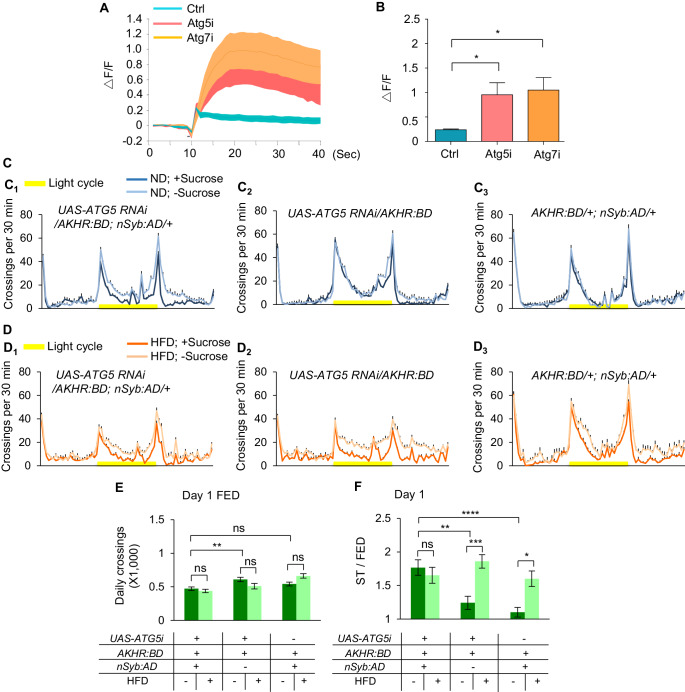
Inhibition of autophagy increases starvation-induced hyperactivity.(A–B) Representative traces (A) and quantification (B) of peak calcium responses of AKHR+ neurons to 316 nM AKH upon suppressing neuronal autophagy in AKHR+ neurons (n = 7–10). (C–D) Midline crossing activity of indicated genotypes and diet treatments assayed in the presence or absence of 5% sucrose (n = 43–62). (E) Average daily midline crossing activity of fed flies assayed in C-D. (F) Starvation-induced hyperactivity of flies assayed in C-D. ns, p>0.05; *p<0.05; **p<0.01; ***p<0.001; ****p<0.0001. One-way and two-wayANOVA followed by post hoc test with Bonferroni correction were used for multiple comparisons when applicable.Figure 4—source data 1.Raw data of the behavioral experiments shown in Figure 4 and Figure 4—figure supplements 1–4.